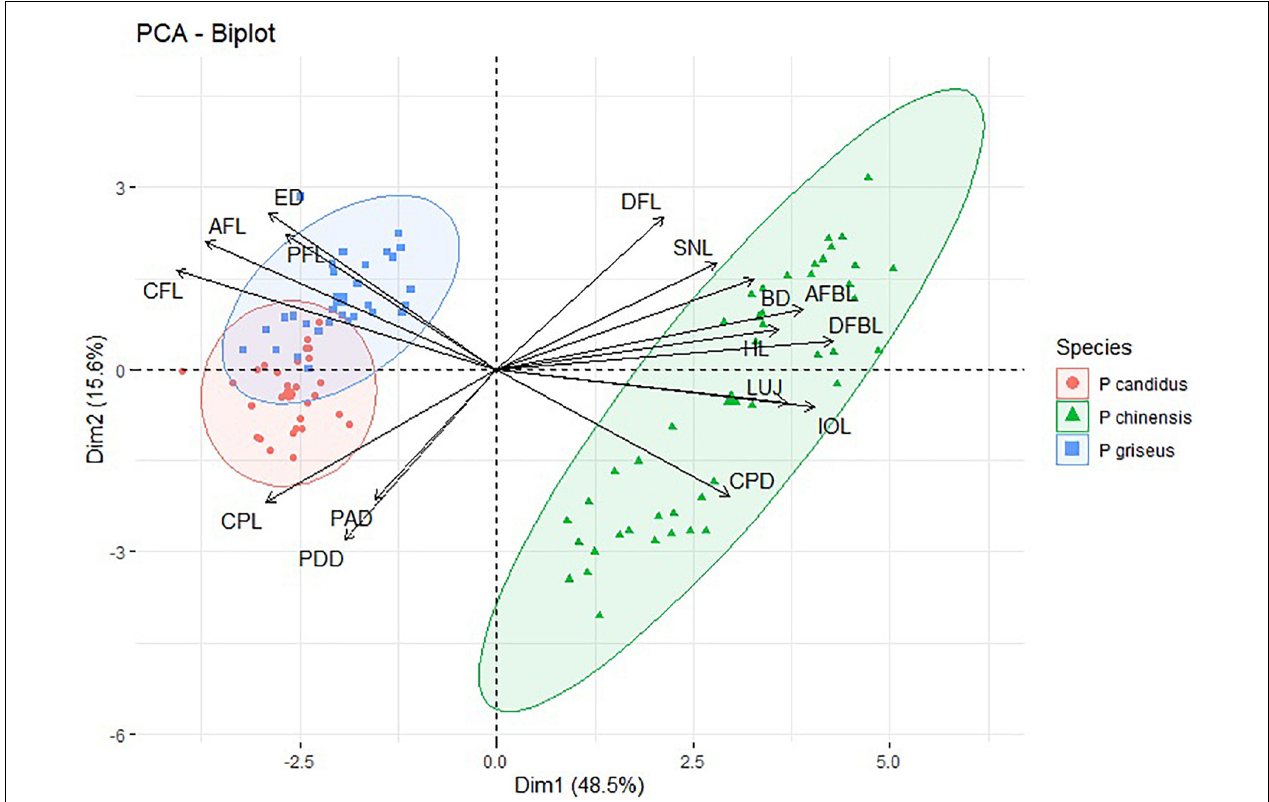
FIGURE 3 | Bi-plot showing the variables and individuals (samples) oriented along the first two principal components with eclipses (species). The Dim1 and Dim2 are the first and second principal component extracted in PCA and the notation in graphs refers to the morphometric variables mentioned in Table 1 .